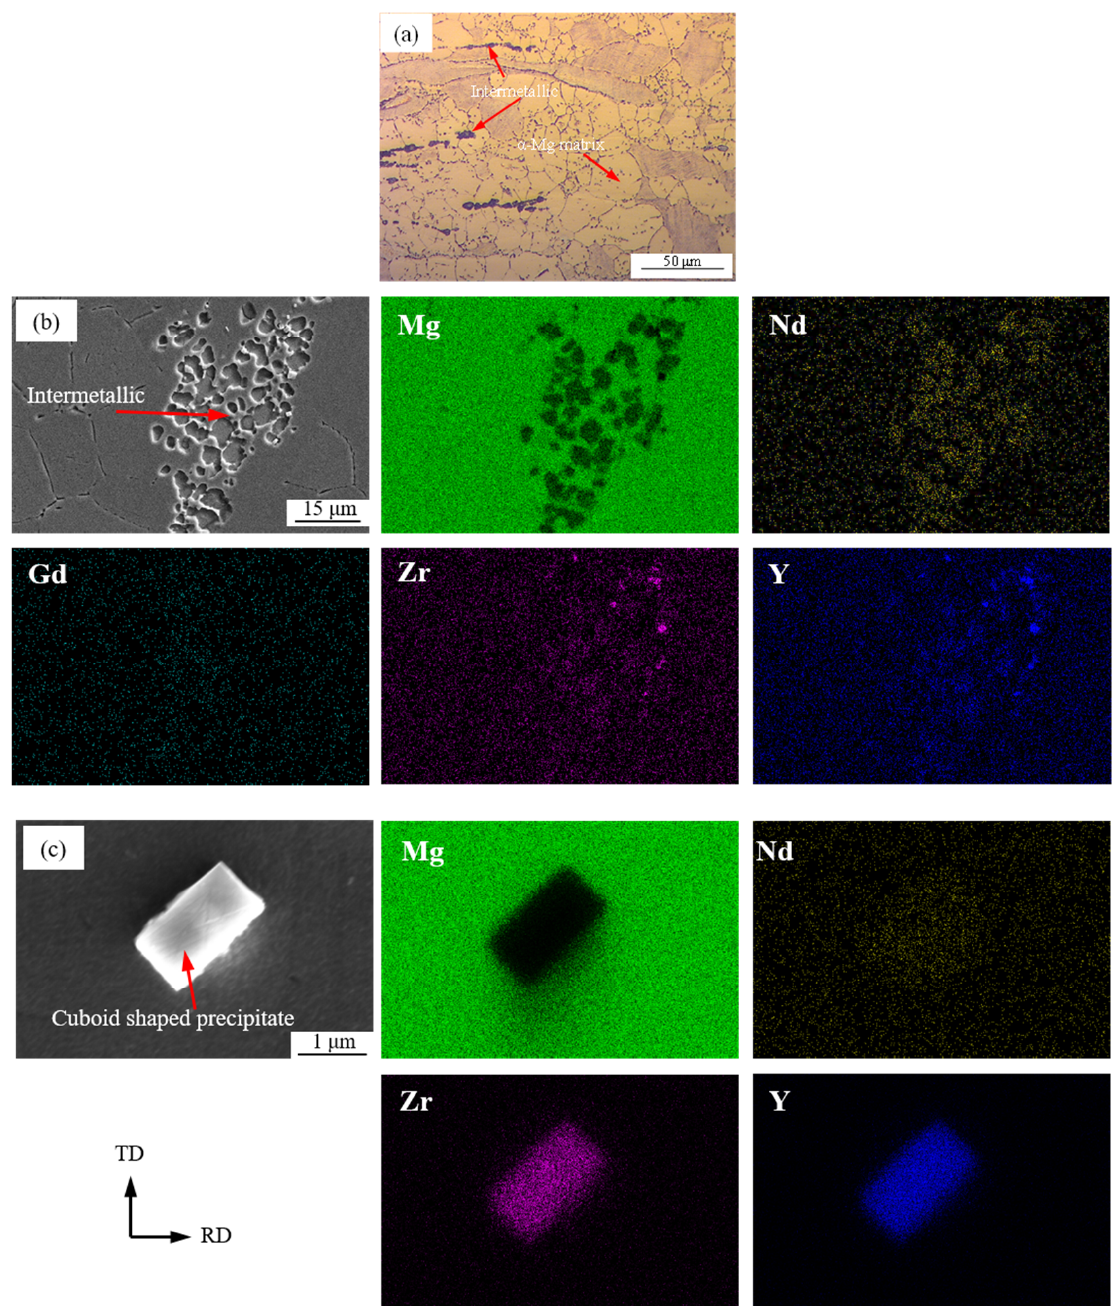
Figure 2. Microstructure of as-received WE43 Mg alloy. ( a ) Optical micrograph of as-received material showing α-Mg matrix and precipitates. SEM image along with EDS map scan presenting elemental distribution showing ( b ) intermetallic, and ( c ) cuboid-shaped precipitate.